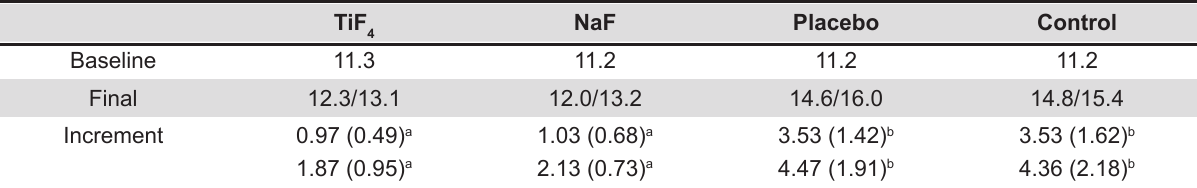
Table 2- Baseline, final and increment dentin erosive wear means (µm), with and without DOM (interquartile range), respectively, according to each treatment